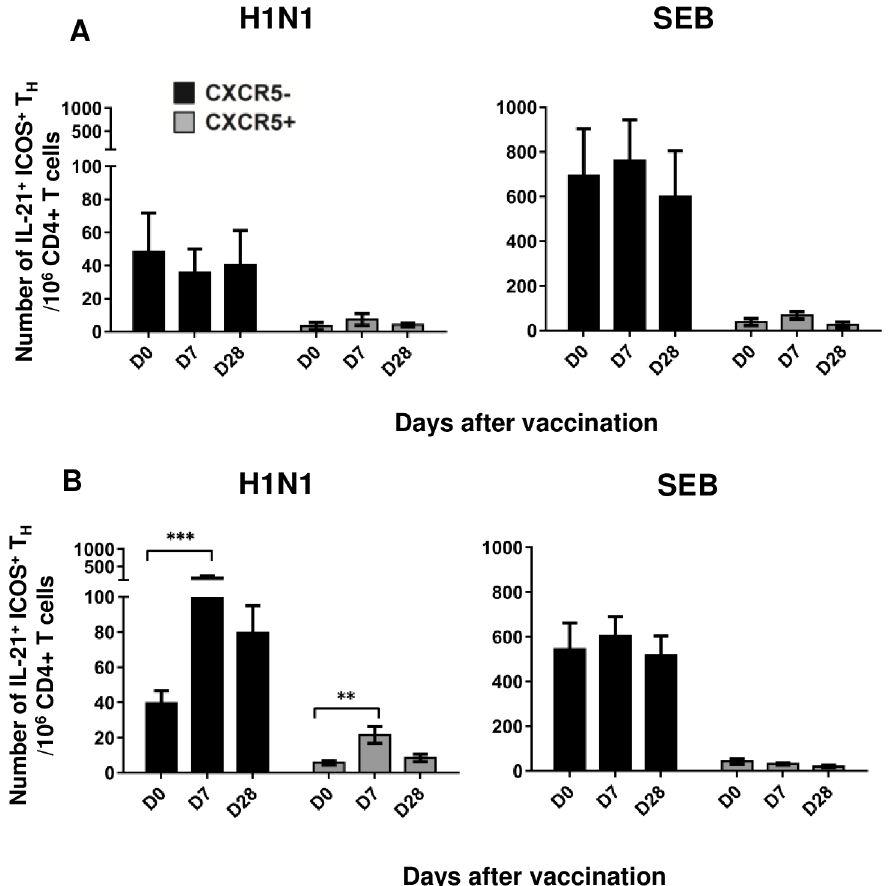
Fig 5. H1N1-specific CD4 + IL-21 + ICOS + T H cells subsets expressing or not CXCR5 expand after influenza vaccination. Number of CD4 + IL-21 + ICOS + T H cells, showing a CXCR5 + (black) or CXCR5 - (gray) phenotype, in vaccinated participants after overnight stimulation with A/California/7/2009 (H1N1) antigen or SEB. Data show saline placebo (n=7), and merged TIIV (n=18) and ATIIV (n=17) cohorts at baseline (D0), day 7 (D7) and day 28 (D28) after a single dose of influenza vaccine. Data are expressed as number of cells in 10 6 live CD4 + T cells; mean ± SEM is shown. Non-parametric Wilcoxon ’ s signed rank test was used for statistical analyses: * p < 0.05, ** p < 0.01, and *** p < 0.001 compared to day